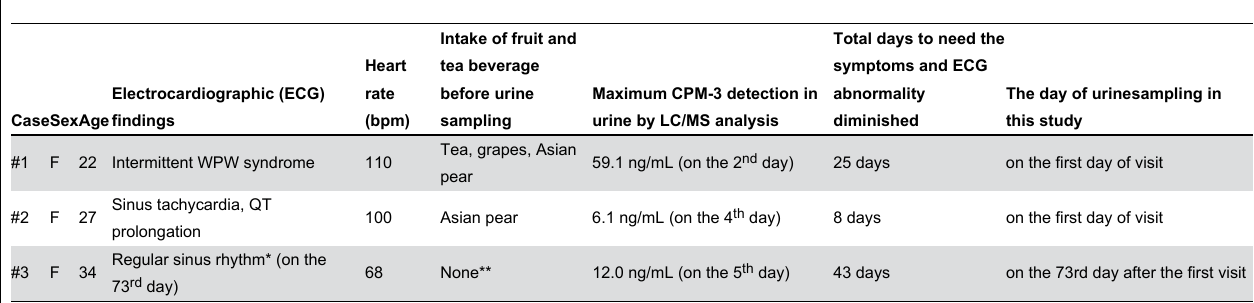
Table 1. Demographic data and clinical findings of patients, who are suspected of subacute neonicotinoid exposure.